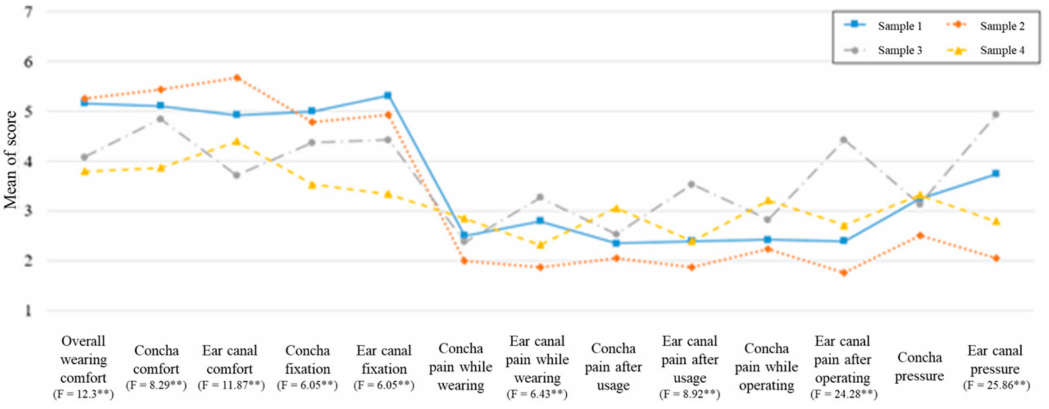
Figure 4. Results of ANOVA for wearing comfort by products (**: p <